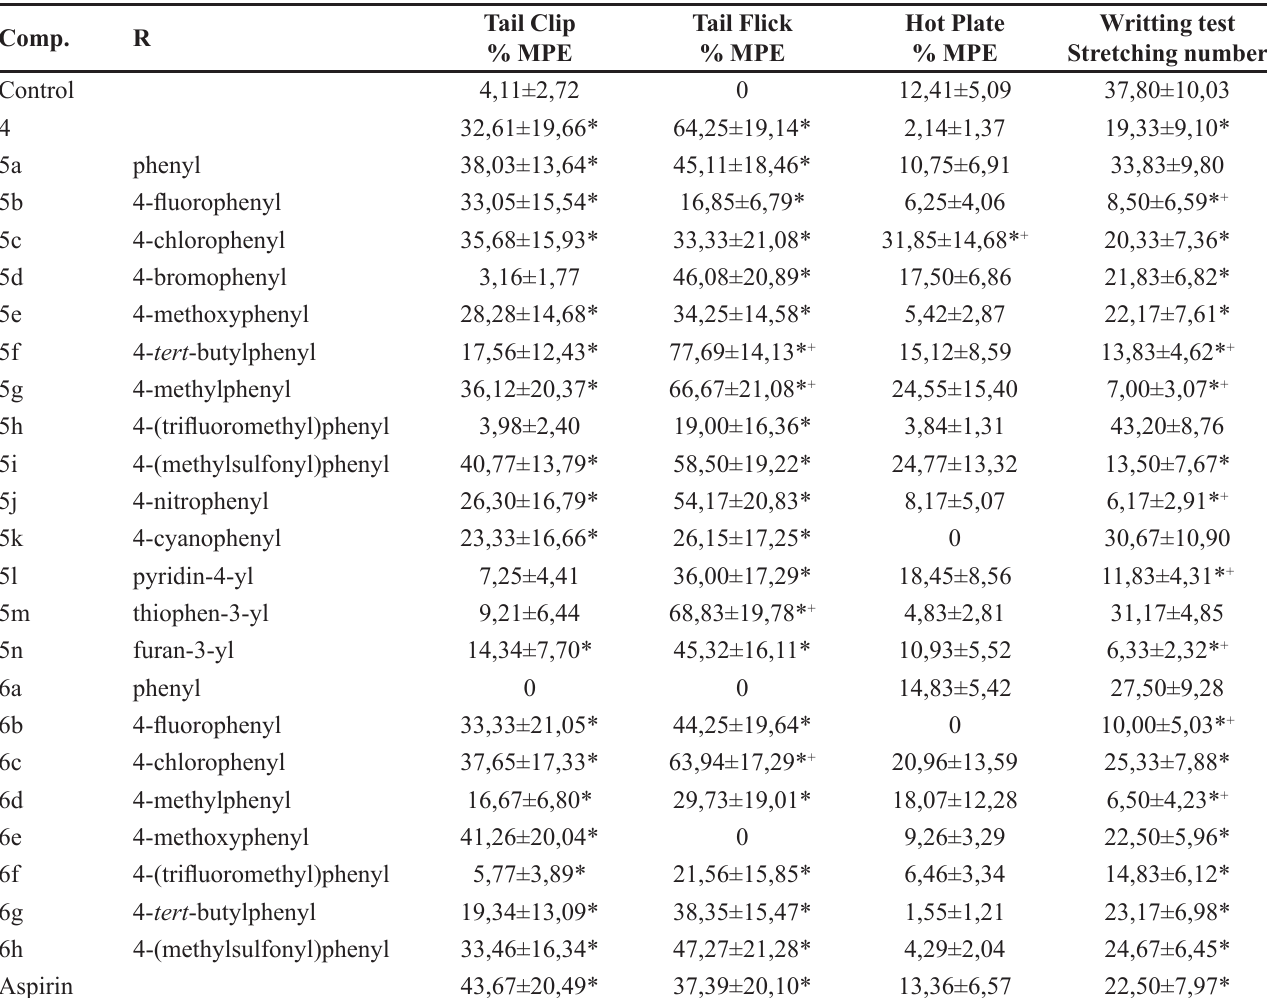
TABLE I - Antinociceptive activity of synthesised compounds